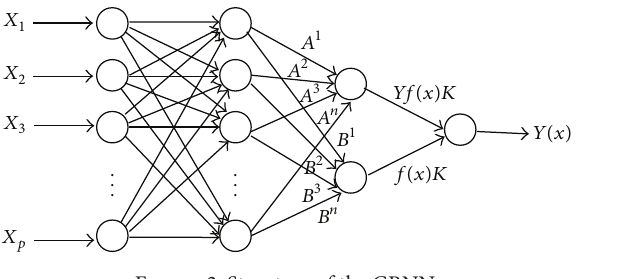
Figure 2: Structure of the GRNN.